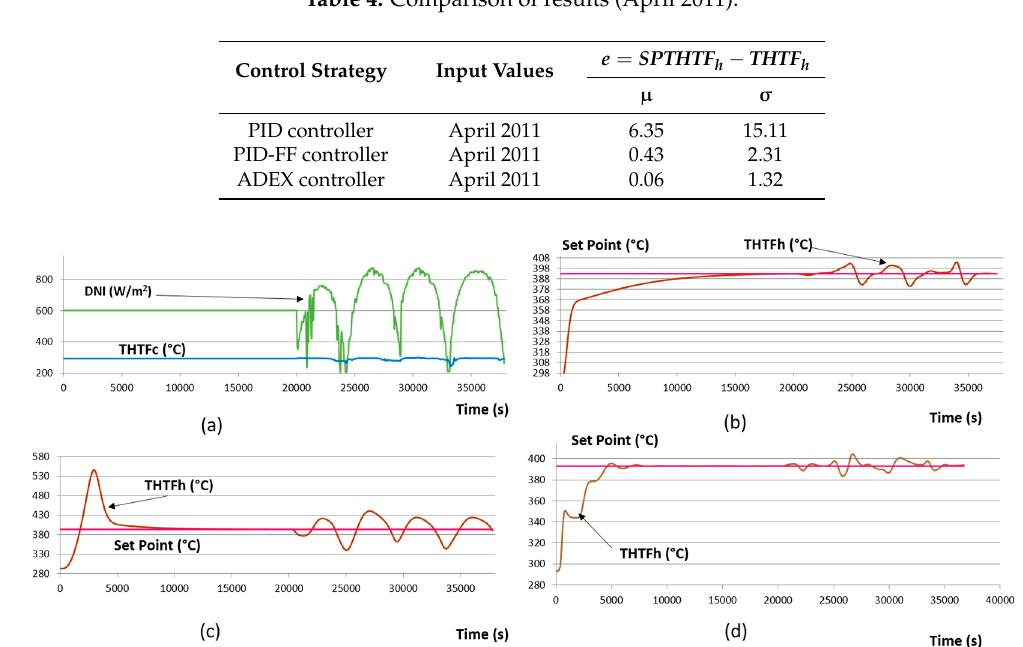
Table 4. Comparison of results (April 2011).